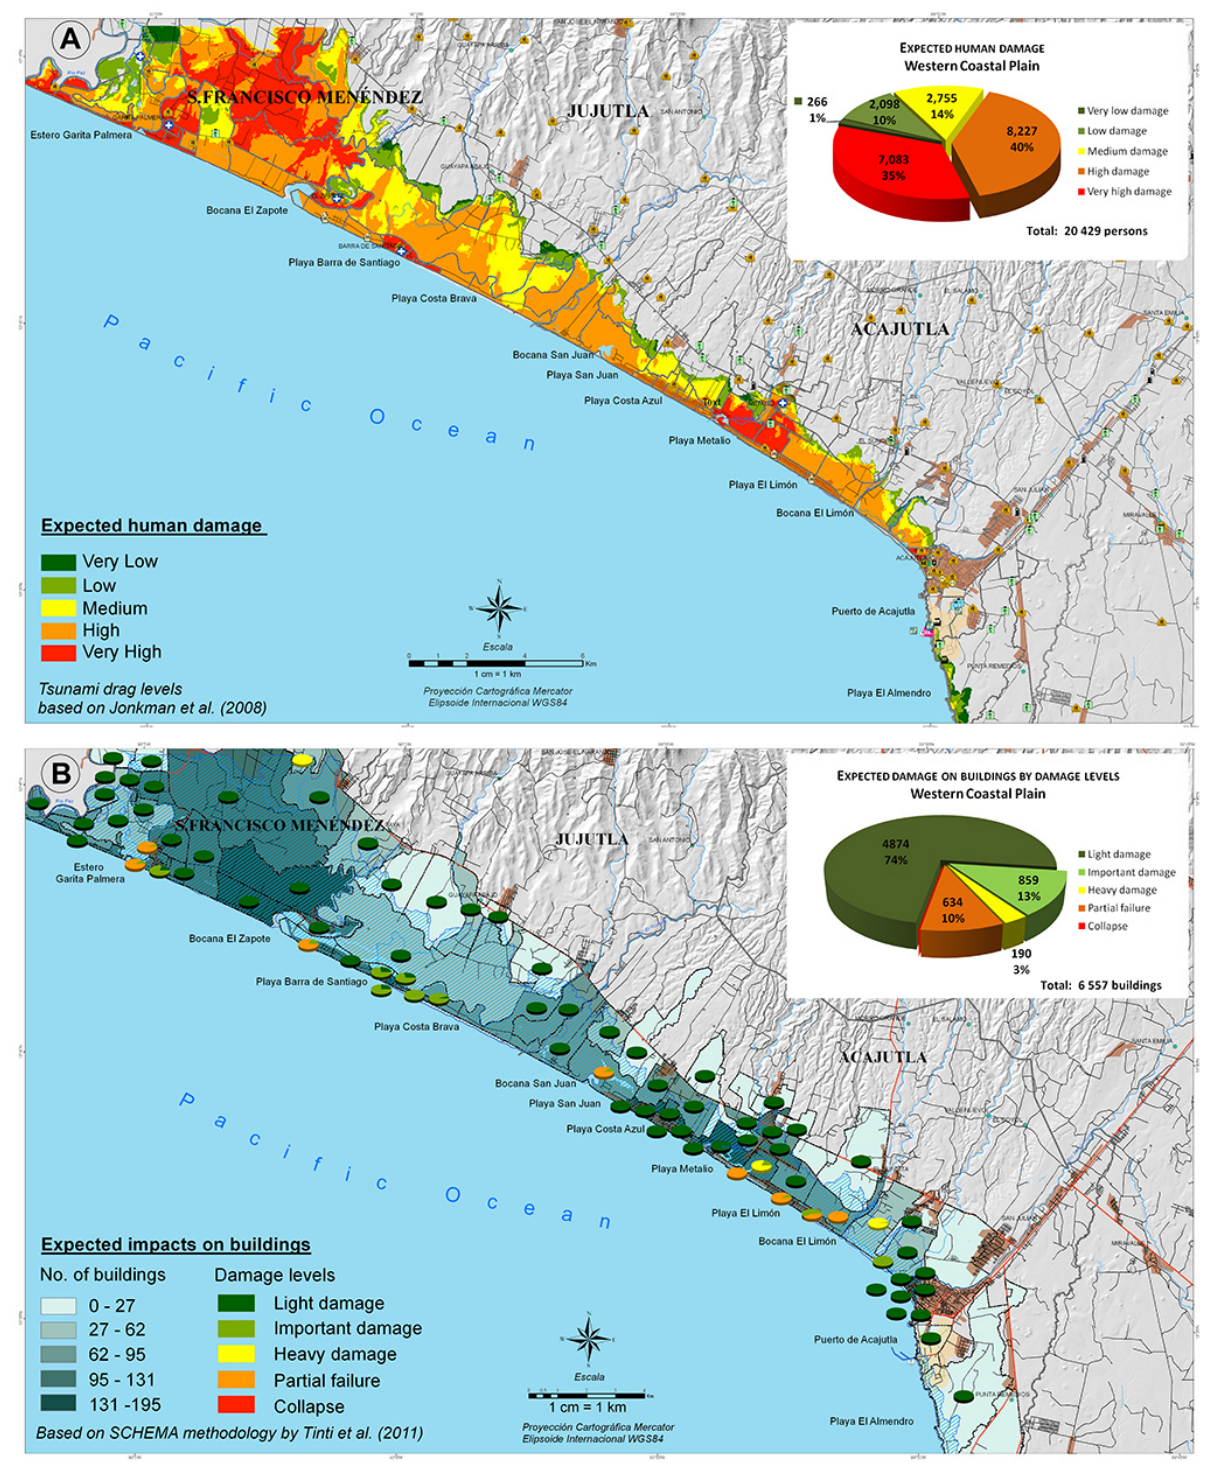
Figure 6. Expected impacts in the Western Coastal Plain of El Salvador: (a) zoning for expected human damage, and (b) expected impacts on buildings by census